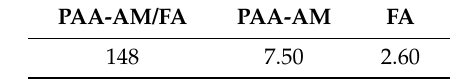
Table 6. The adsorption capacity for Rhodamine B by different superabsorbent composite (mg · g − 1 ). PAA-AM/FA